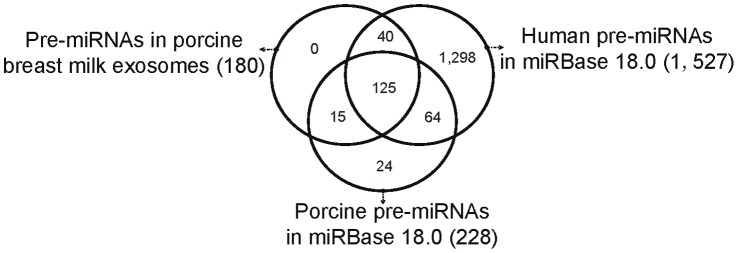
Distribution of shared pre-miRNAs among miRBase (Version 18.0) entries for human (1,527) and pig (228), as well as 180 pre-miRNAs identified in porcine breast milk exosomes.Out of 180 pre-miRNAs in porcine breast milk exosomes, 140 are known porcine pre-miRNAs and 40 are novel porcine pre-miRNAs, which encoding 237 mature miRNAs, corresponding to 234 unique miRNAs.